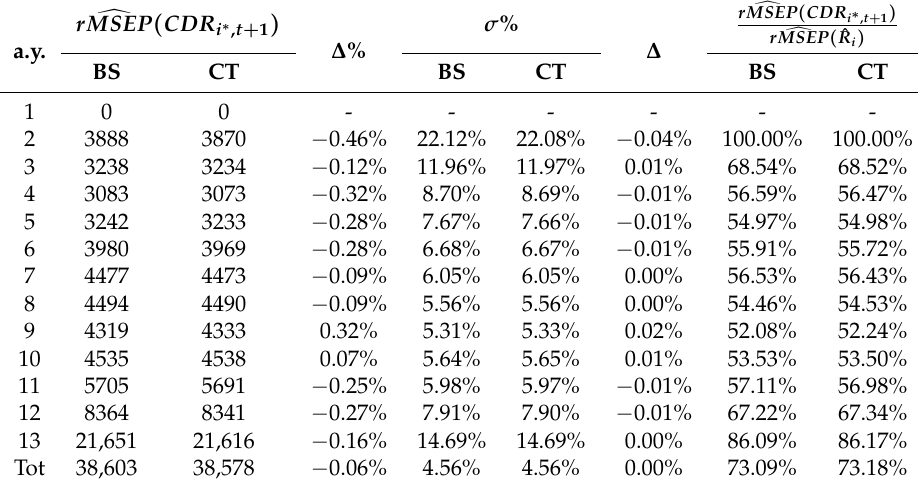
Table 6. Estimation of rMSEP one-year: bootstrapping vs. closed tool.